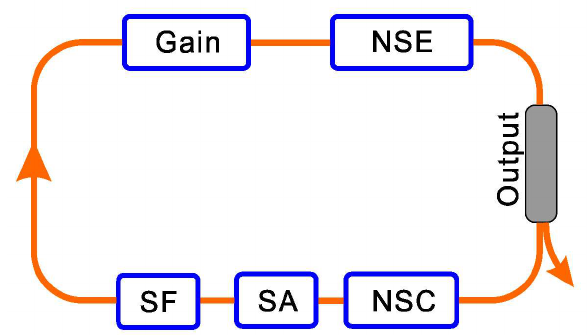
Figure 10: Illustration of a self-similar few cycle fiber laser. NSE: Nonlinear spectral expansion, NSC: Nonlinear spectral compres- sion, SA: Saturable absorber, SF: Spectral